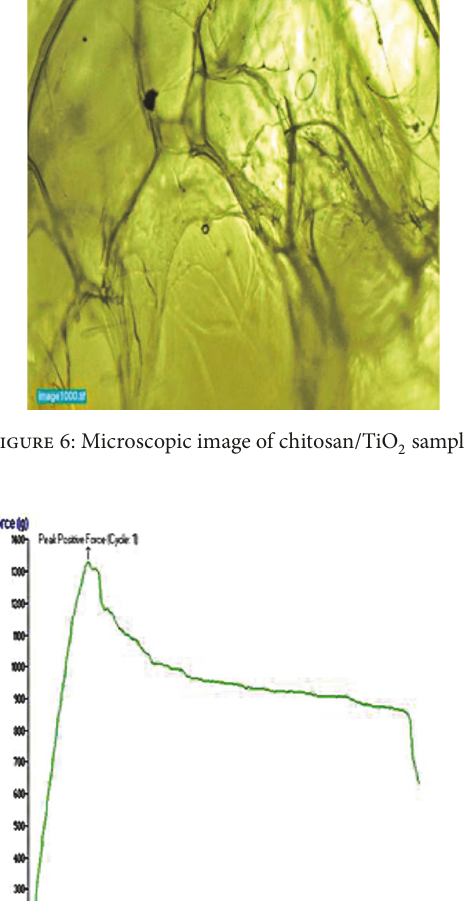
Figure 9: Cell proliferation on chitosan/TiO 2 scaffolds as a function of